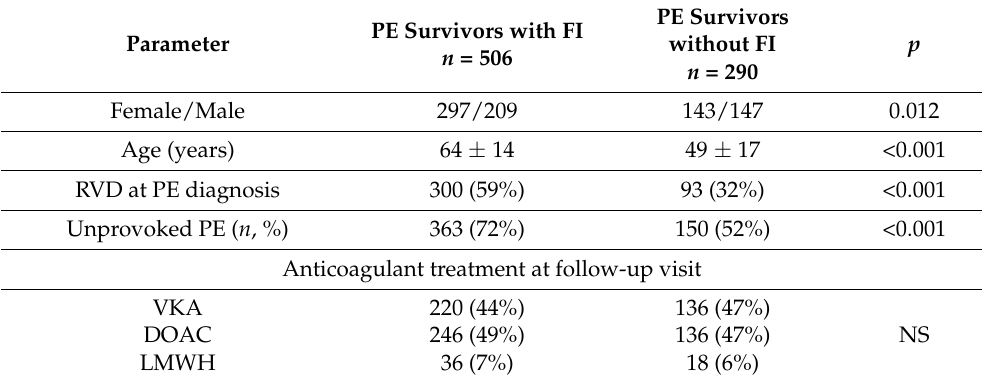
Table 2. Characteristic of pulmonary embolism survivors with and without functional